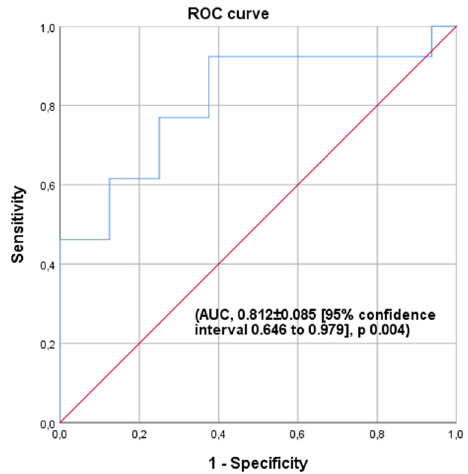
Figure 2. ROC curve for SERCA2a. Area under the curve (0.812 ± 0.085; p = 0.004). The 95% confidence interval was set between 0.646 ng/mL and 0.979 ng/mL, with a cutoff point at 0.84 ng/mL.